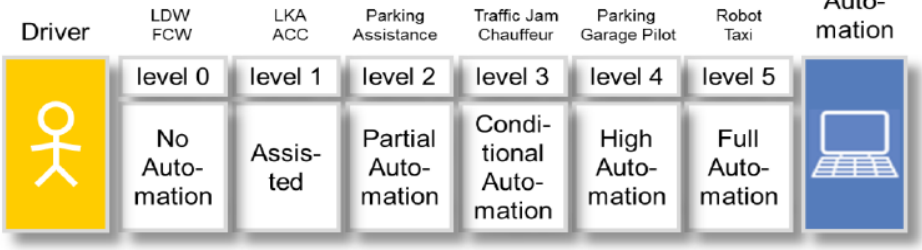
Figure 1. SAE autonomous level.